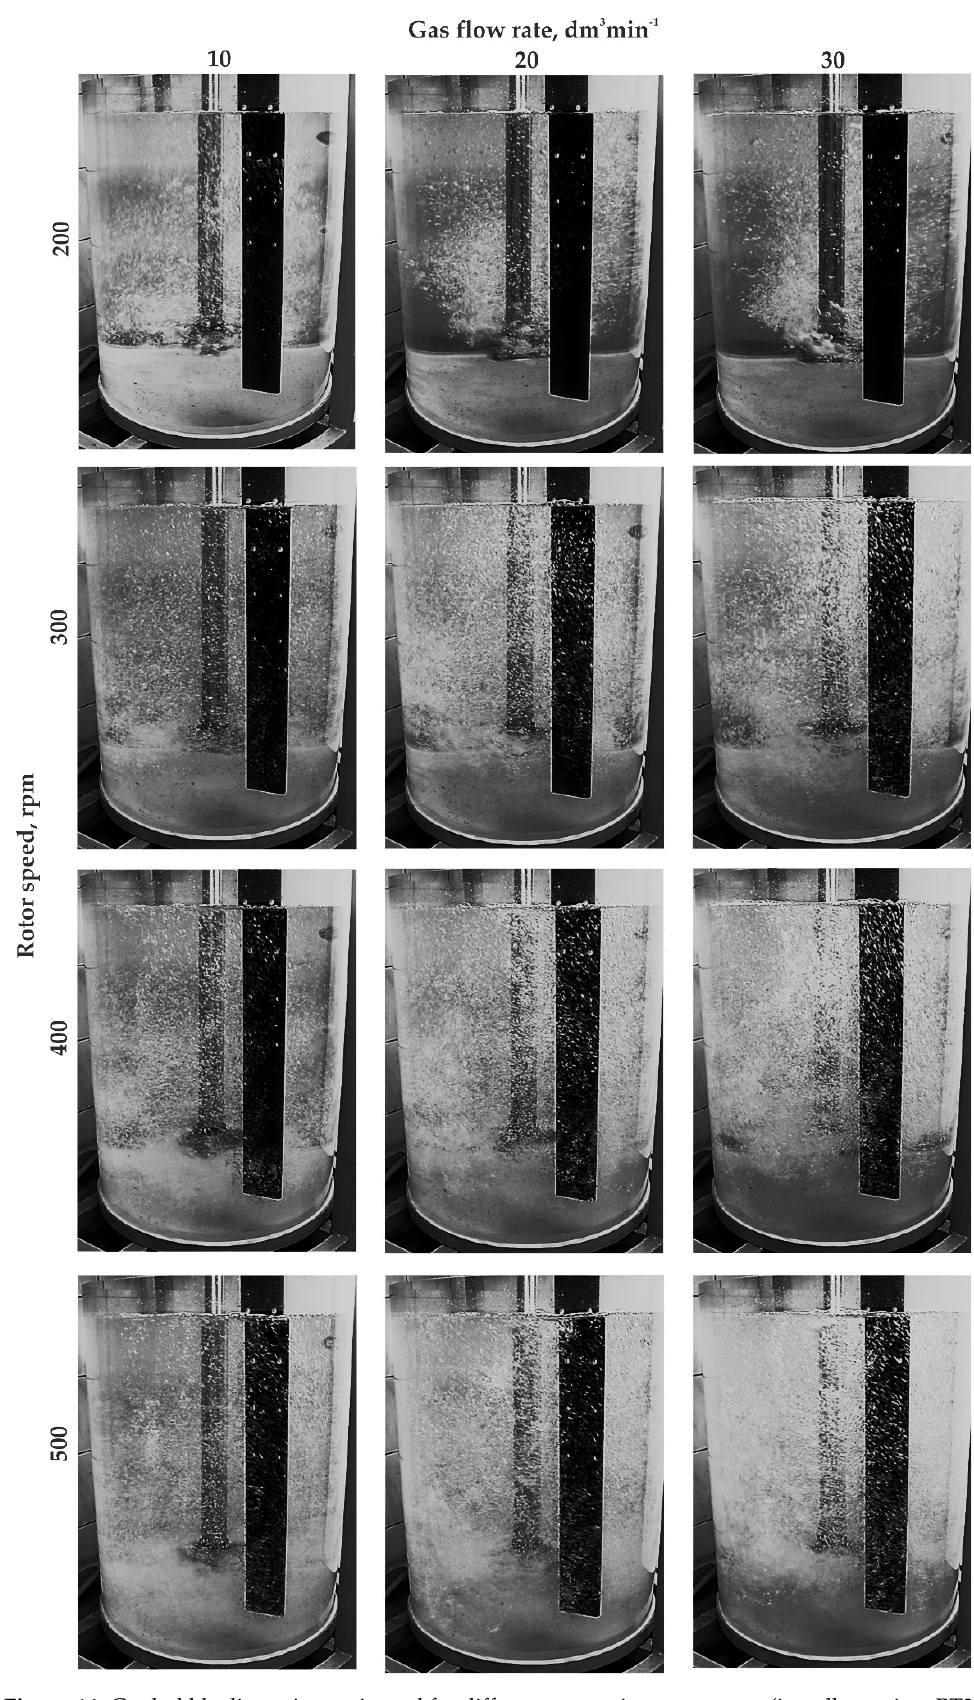
Figure 14. Gas bubble dispersion registered for different processing parameters (impeller variant RT3).